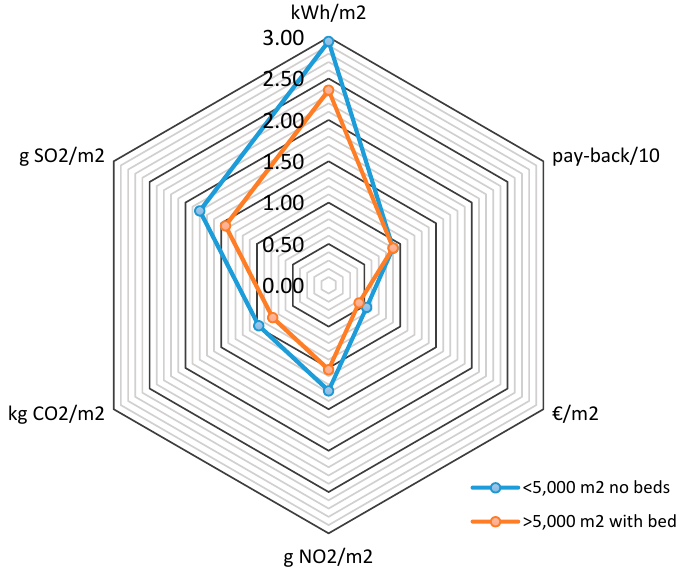
Figure 5. Potential of energy saving derived from usage of renewable energies.